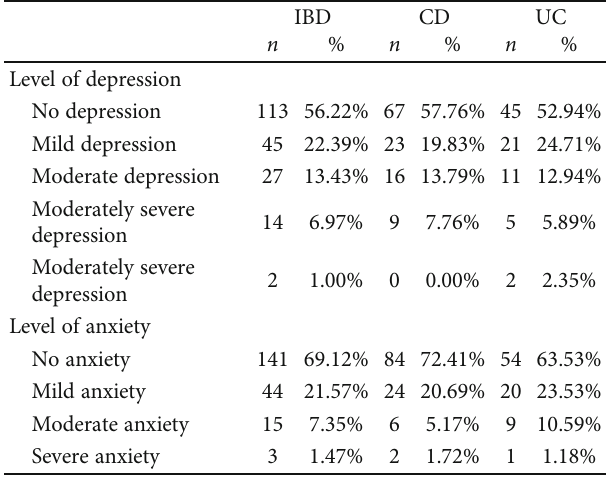
Table 3: Psychological status in IBD patients during the COVID-19